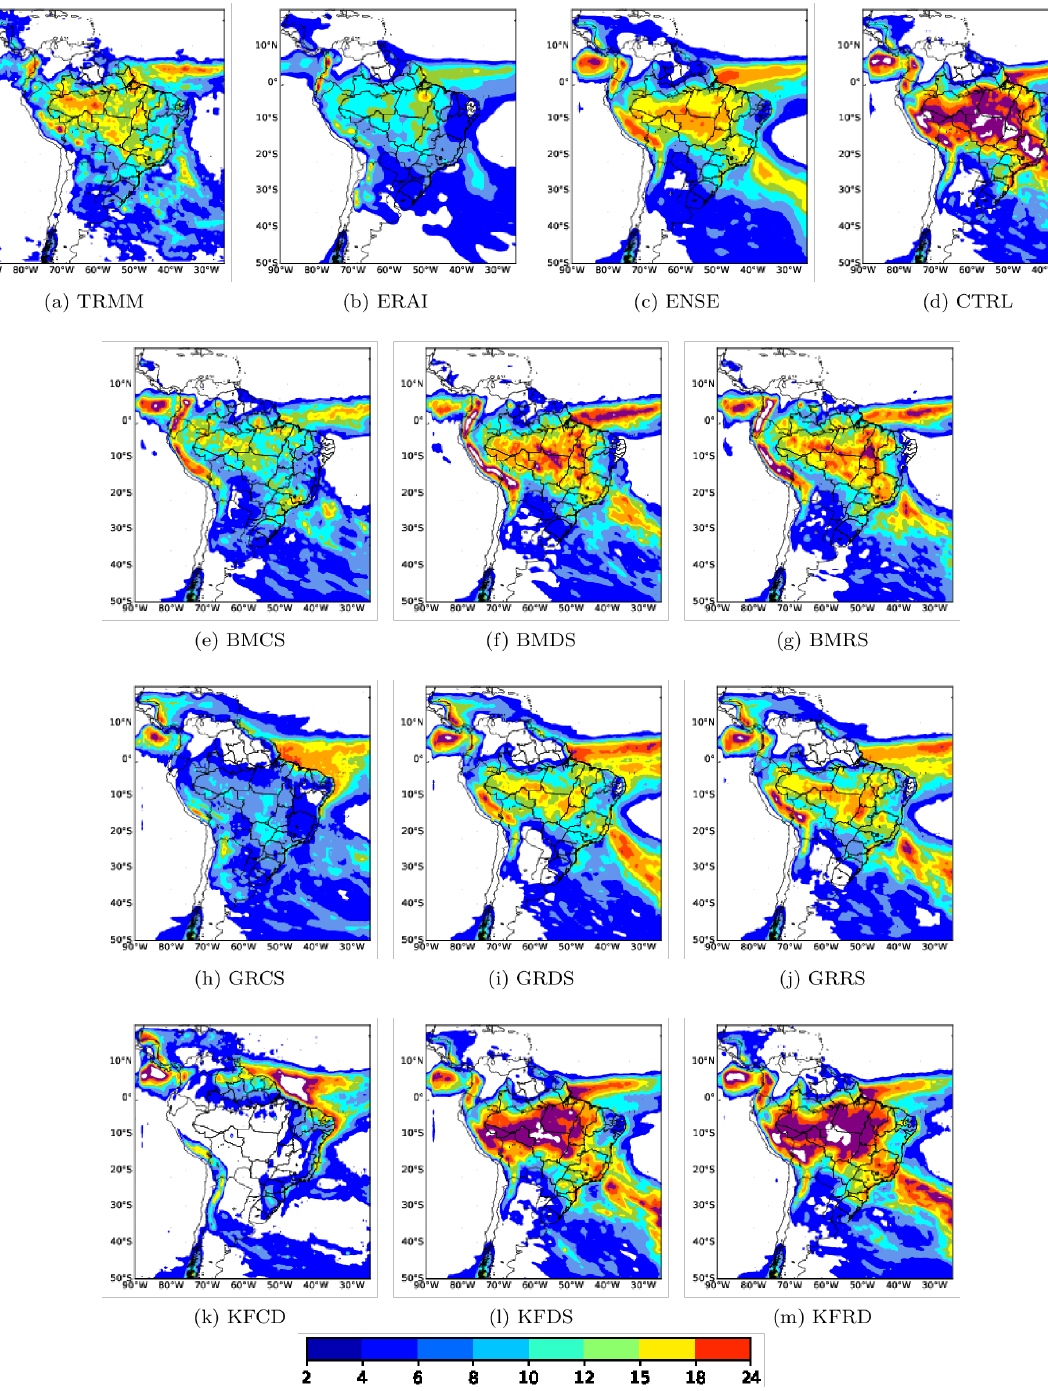
Figure 3. Precipitation fields for December–January–February (in mm/day). The first line of plots is for TRMM, ERAI, ENSEMBLE, and control simulations (CTRL). The next lines represent one of each member, as described in Figure